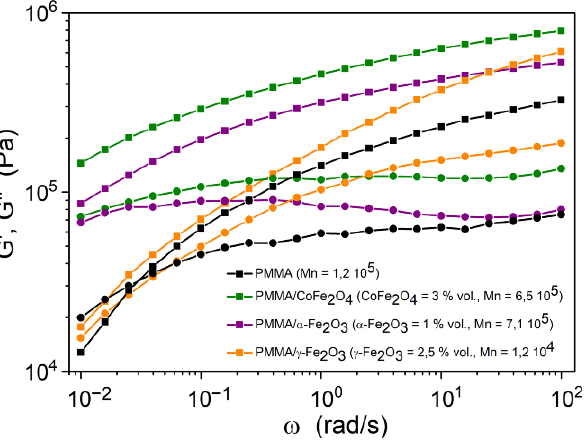
Figure 9. Variation of the storag e G′ ( ■ ) and loss G ″ ( ● ) moduli of pure PMMA and of PMMA chains grafted onto the surface of NPs (PMMA/NPs), as a function of frequency ω at a temperature of 210 °C .